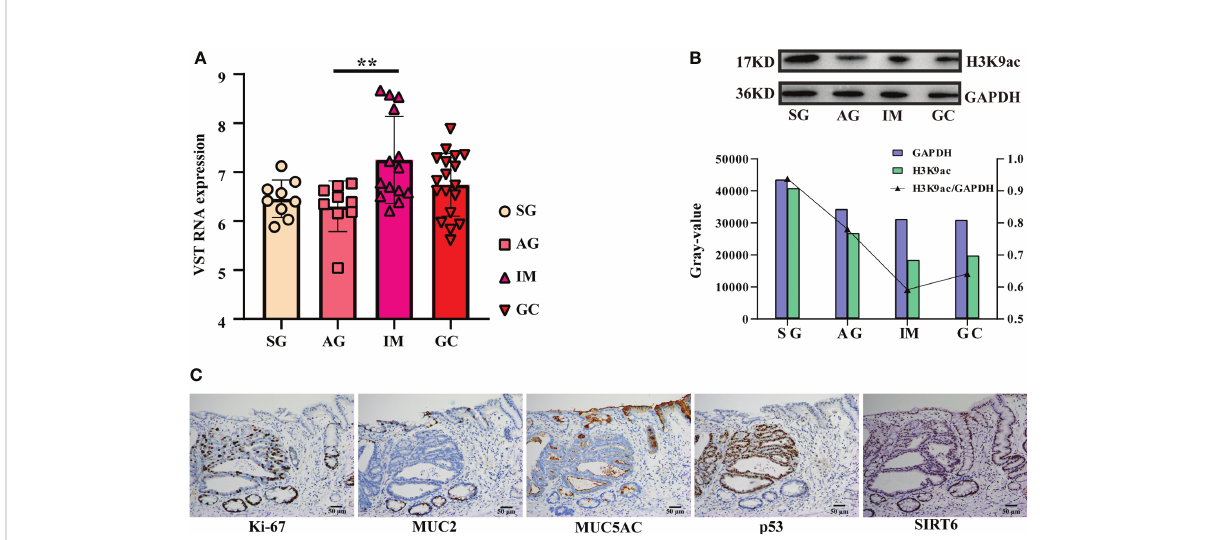
FIGURE 7 Detection and exploration on SIRT6 . (A) Bar plot exhibiting the SIRT6 ’ s expression from SG to the GC lesion. The symbol ** means FDR adjusted p value for the mean difference was less than 0.01 (B) Western blotting against H3K9ac(17KD) and GAPDH (36KD). The bar plot illustrating grayscale ratio of H3K9ac and GAPDH. (C) Immunohistochemistry against Ki-67, MUC2, MUC5AC, p53, and SIRT6 on an endoscopic submucosal dissection tissue.